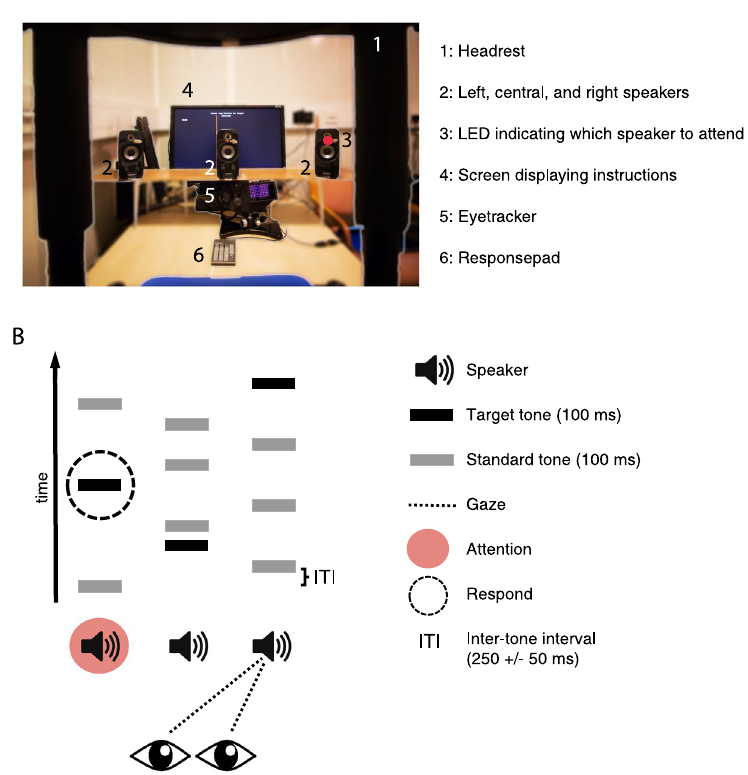
Figure 1. Setup and trial design. ( A ) View from the participants’ perspective. ( B ) Schematic experimental design. Continuous streams of sounds were simultaneously presented from each of the three loudspeakers. The sound streams consisted of both standard and target auditory stimuli. On each trial, participants were instructed to attend one of the three loudspeakers (here: left speaker), and visually gaze at either the same of a different speaker (here: right speaker). The task was to provide speeded responses to target sounds coming from the attended